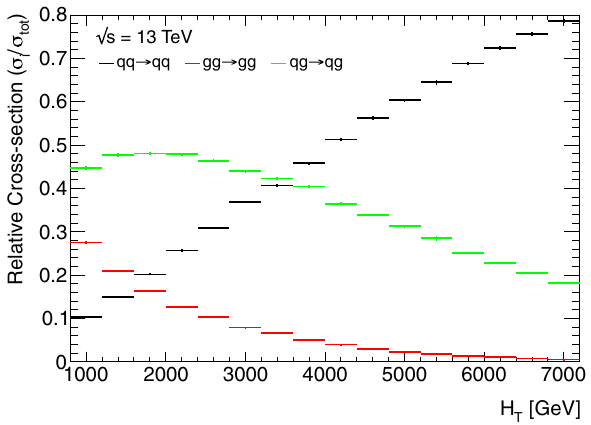
Fig. 2 The relative cross-sections at LO of the 3 leading subprocesses. Events were generated using Pythia